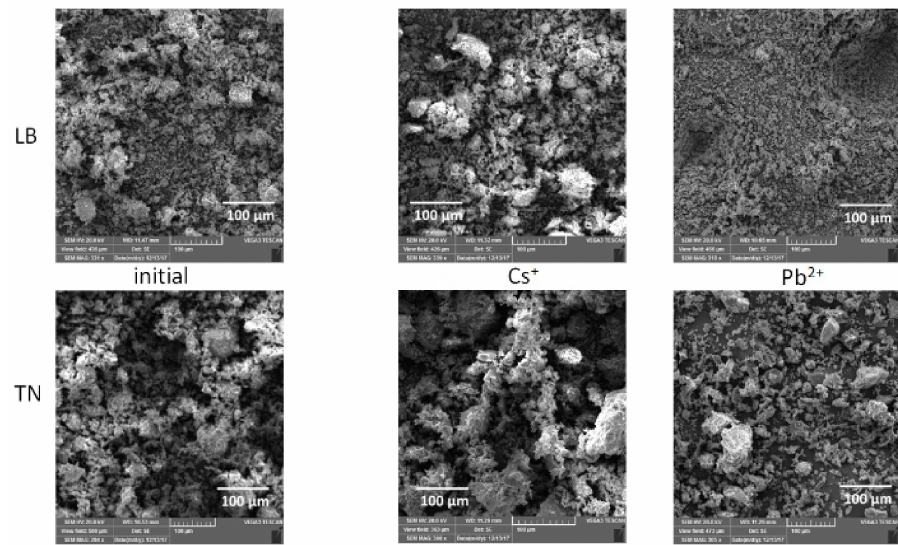
Figure 2. SEM images of WBD before and after Cs + / Pb 2 + adsorption on LB and TN (magnification of 300 ×